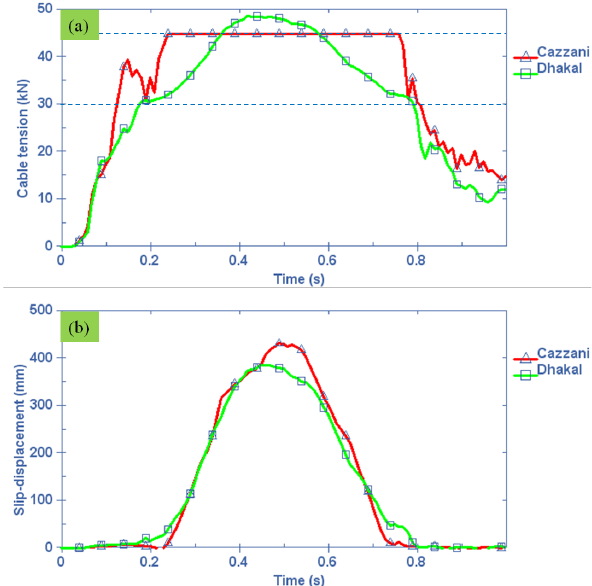
Figure 19. Numerically simulated time histories of maximum cable tension (a) and corresponding maximum slip-displacements (at location M in Fig. 1) (b) in the R-LPR installed with the UFDs having the Cazzani-LPR Brake Model and the Dhakal-LPR Brake Model respectively as the constitutive models, and subject to impact energy of 150 kJ. The higher value of maximum tension in the cable in the Dhakal-LPR Brake Model case implies that it better utilizes the capacity of cable than the Cazzani-LPR Brake Model.